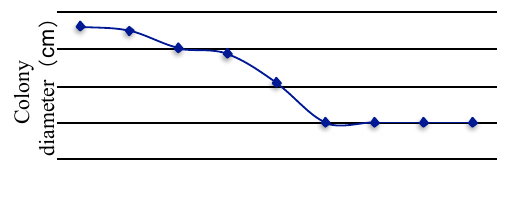
Figure 1. Mean diameter of Lasiodiplodia theobromae colo- nies incubated for 2 d on PDA containing different concen - trations of hygromycin B.